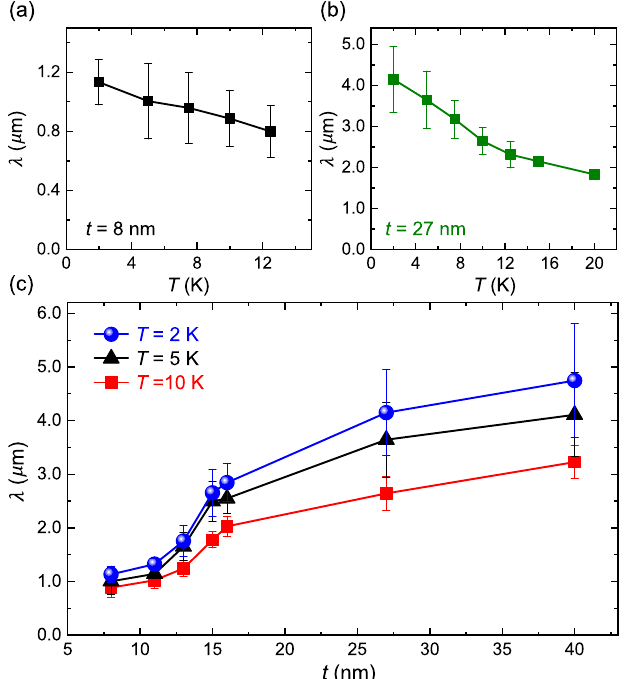
FIG. 4. Thickness dependence of magnon relaxation length of quasi-2D antiferromagnet MnPS 3 . (a),(b) The magnon relaxation length as a function of temperature for the 8- and 27-nm MnPS 3 devices, respectively. (c) The MnPS 3 thickness dependence of the magnon relaxation length obtained at T ¼ 2 , 5, and 10 K,